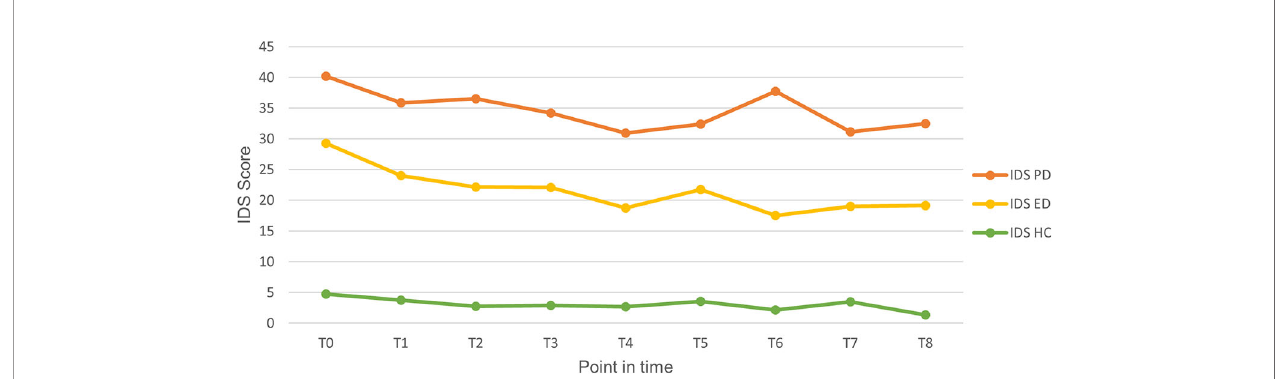
FIGURE 2 | Course of depressive symptom severity for each point in time in the period of two years. ED, Episodic depression; HC, Healthy controls; IDS, Inventory of Depressive Symptomatology; PD, Persistent